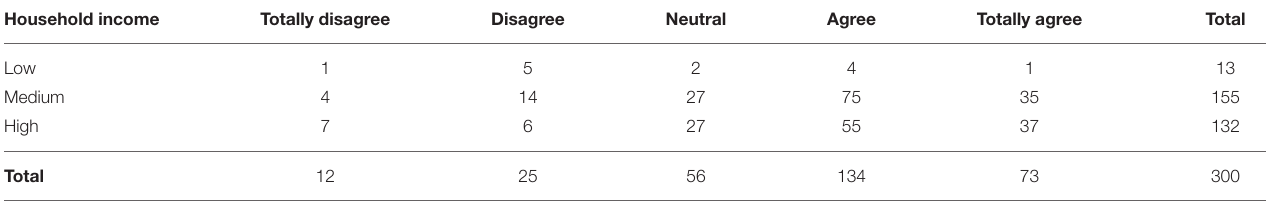
TABLE 5 | Contingency table of the household income and purchase of locally grown food. Household income